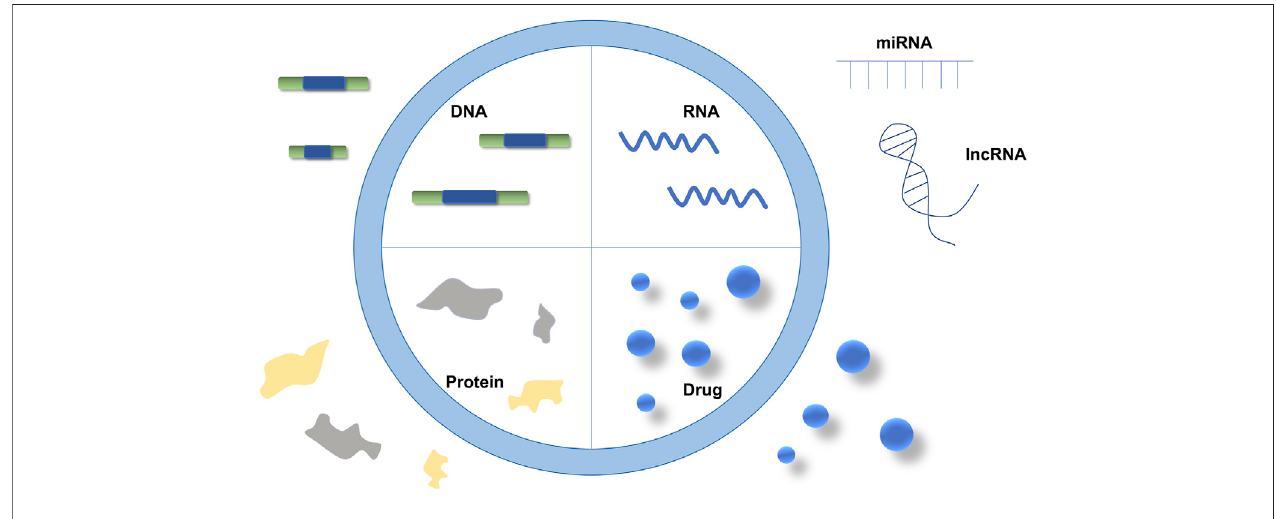
FIGURE 2 | The contents of EVs.